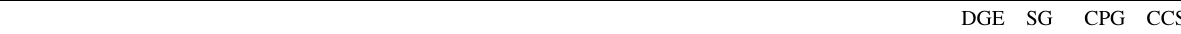
Table 1 Cronbach’s alpha by each technology Perception technology Please indicate, what you spontaneously think of the technology. I find the technology …